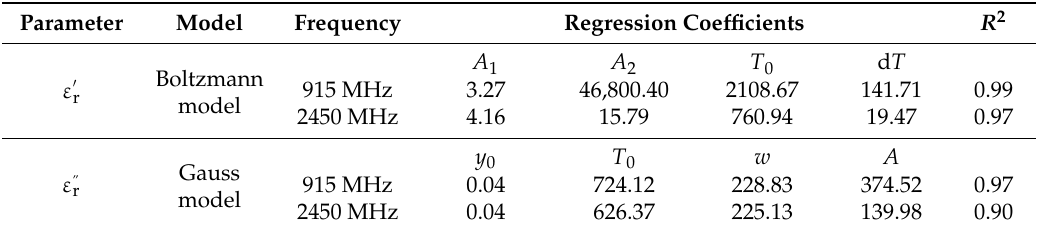
Table 3. Regression coefficients and R 2 values for Boltzmann model and Gauss model fitted to the dielectric properties experimental